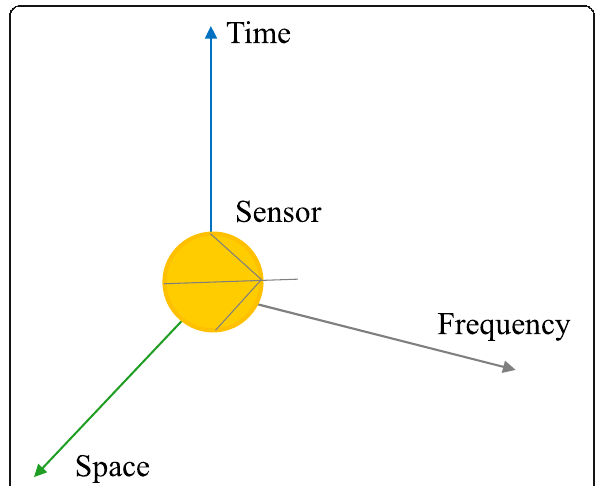
Fig. 1 Sensing node definition in three-dimension domain. Figure shows sensing node definition in three-dimension domain